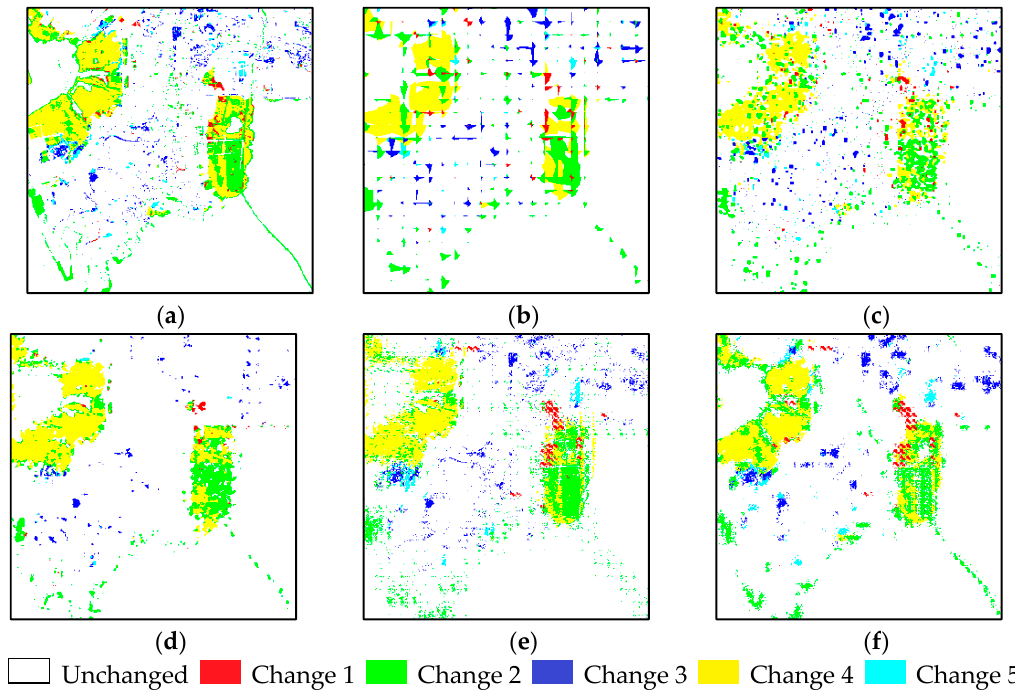
Figure 11. The SLCCD_DR results of the real data set for the five SPM methods. ( a ) Reference of the change map ( b ) BI ( c ) PSA ( d ) HNN ( e ) BPNN_SPM ( f ) BPNN_DR.